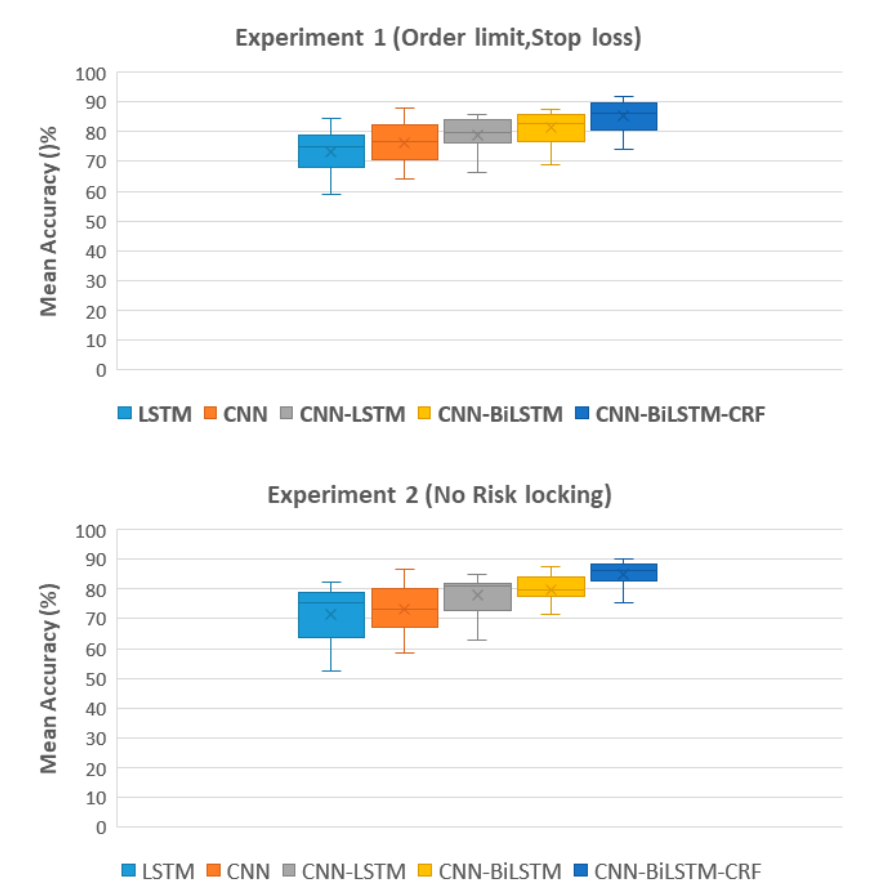
The numbers in bold represent the mean accuracy. ** denotes the highest accuracy reported.